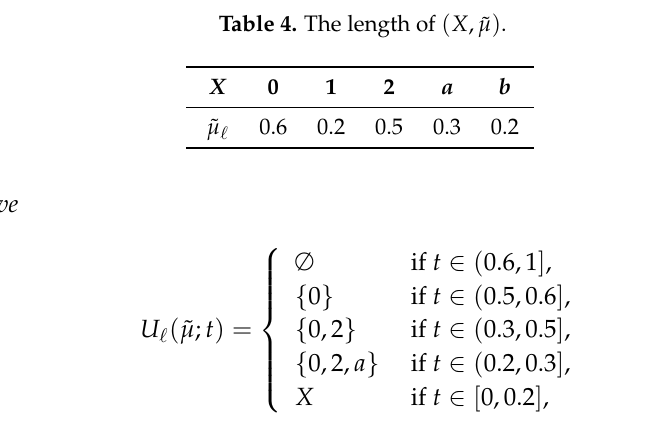
Table 4. The length of ( X , ˜ µ )